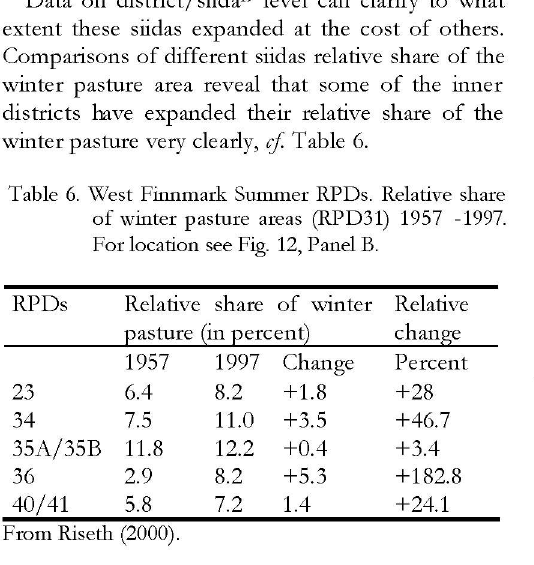
Table 7. Average slaughter weights 1997-2000. Chosen inner RPDs and WF average.